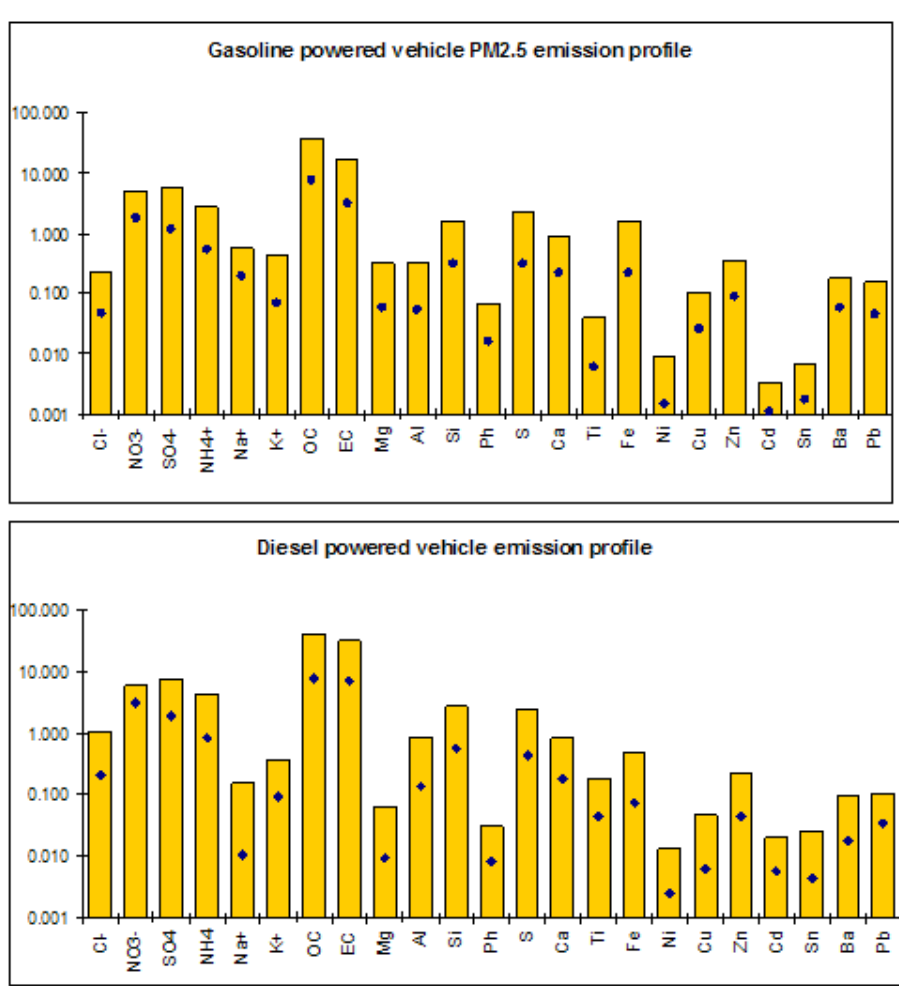
FIGURE 2. Comparison of gasoline- and diesel-powered vehicle PM 2.5 emission profiles. Dots represent uncertainties.